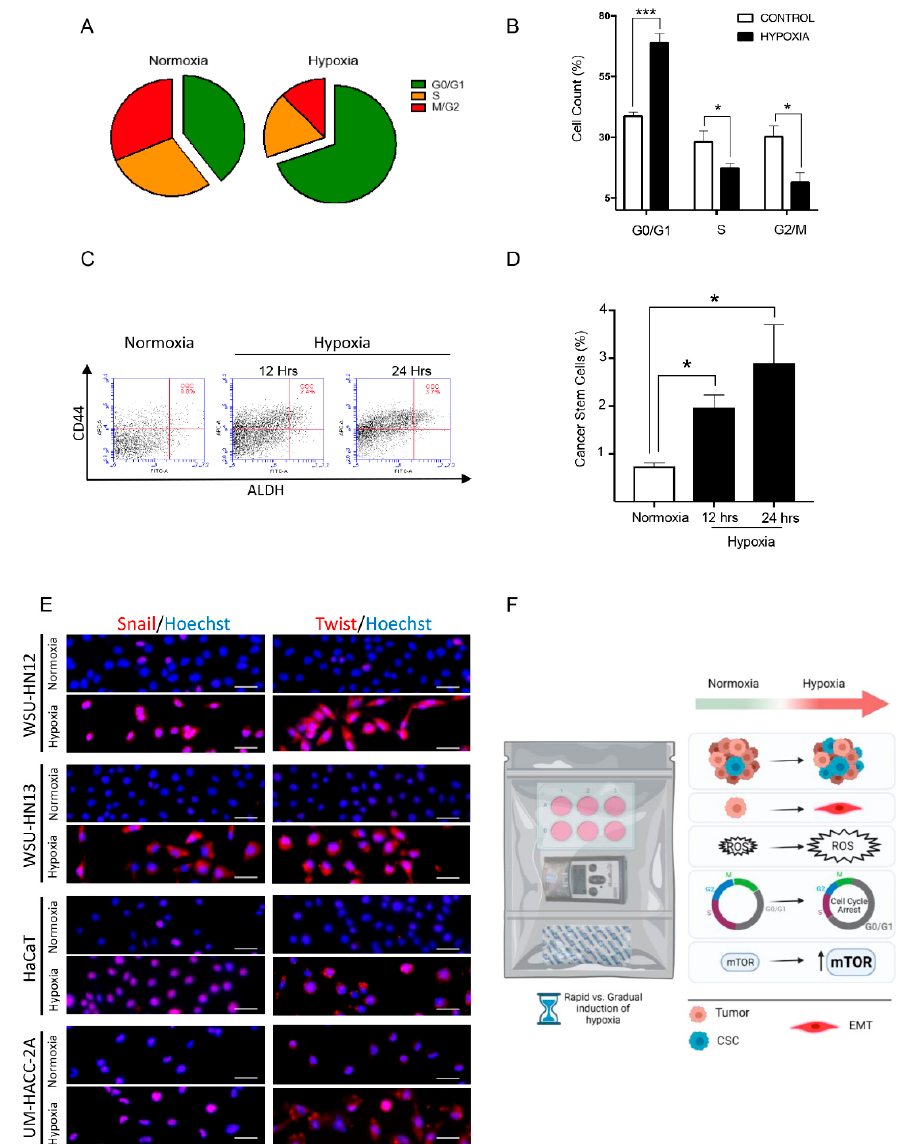
Figure 4. Deoxidizing absorbers method induces cell cycle arrest, accumulation of cancer stem cells, and accumulation of Snail and Twist. ( A , B ) The pie graphic demonstrates an increased number of cells in the G0/G1 phase under hypoxia compared to normoxia (*** p < 0.001). ( C , D ) Deoxidizing absorbers induced the continuous accumulation of cancer stem cells measured at baseline (normoxia), 12 h, and 24 h (ALDH + /CD44 ++ positive cells) (* p < 0.05). ( E ) Immunofluorescence staining for Snail and Twist on 4 different epithelial cell lines. WSU-HN12 and WSU-HN13 are squamous cell carcinomas, HaCaT is a human immortalized skin cell line, and UM-HACC-2A is a salivary gland adenoid cystic carcinoma cell line. Note the weak immunofluorescence staining for Snail (Alexa 568—red) in all 4 cell lines cultured under normoxia compared with hypoxic conditions (scale bar 50 µm). Immunofluorescence staining for Twist (Alexa 568—red). Note the weak staining in all 4 cell lines cultured under normoxia and accumulation of Twist in all cell lines during hypoxia. Hoechst 33,342 counterstaining for DNA content is in blue (scale bar 50 µm). ( F ) Diagram representing the biological effects of deoxidizing-absorbers-induced hypoxia over epithelial cells. Deoxidizing absorbers may be used to achieve rapid vs. gradual onset of hypoxia. They are also effective in triggering the EMT phenotype in epithelial cells, increasing the intracellular levels of ROS, activating the mTOR pathway, inducing cell cycle arrest (G0/G1), and in promoting the accumulation of cancer stem cells.